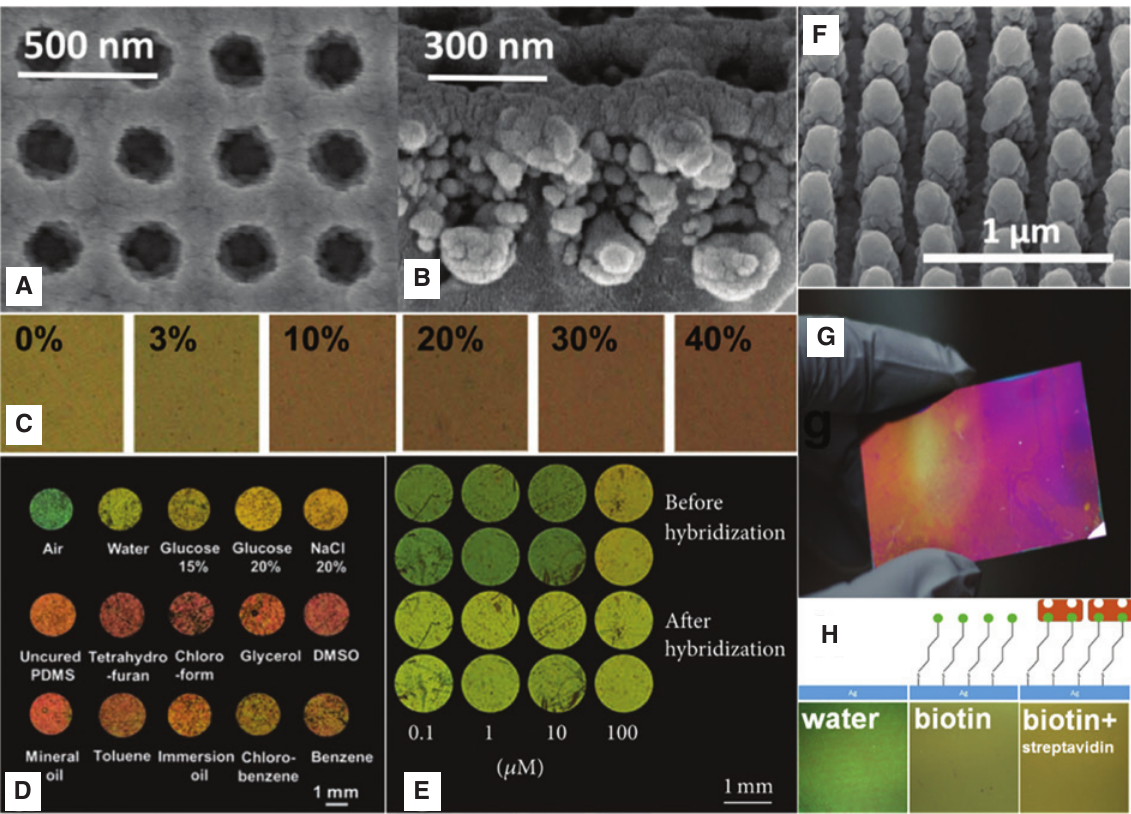
Figure 1: Ultra-sensitive plasmonics sensors for refractive